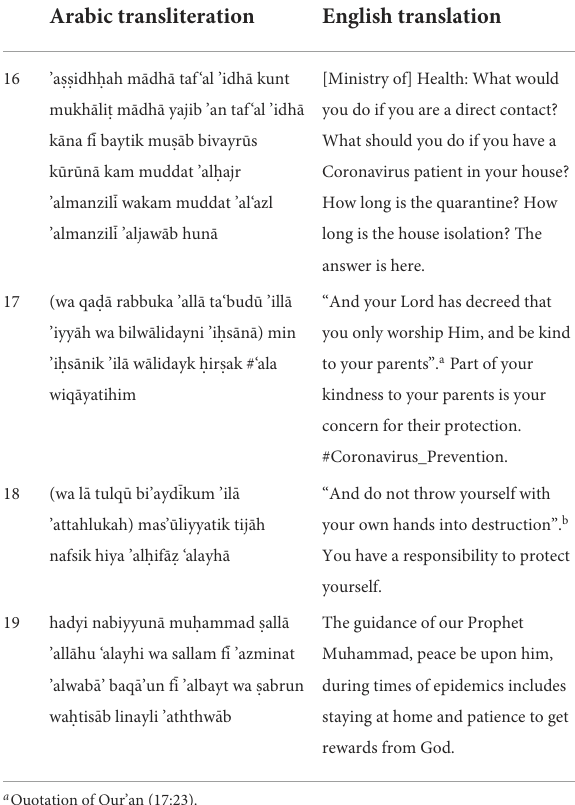
TABLE 6 Examples of the use of the authority